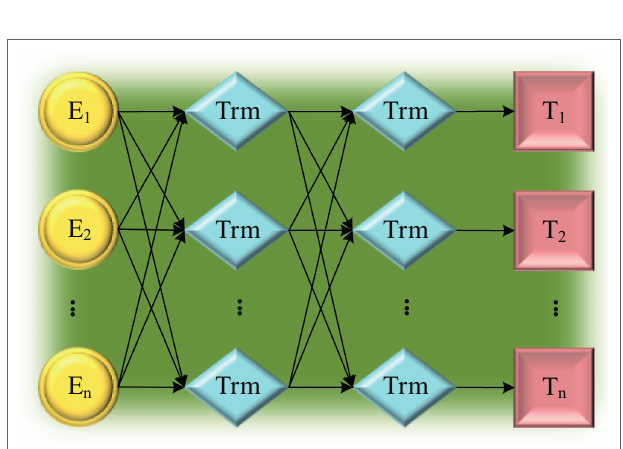
FIGURE 5 | Bidirectional encoder representation from transformers (BERT)